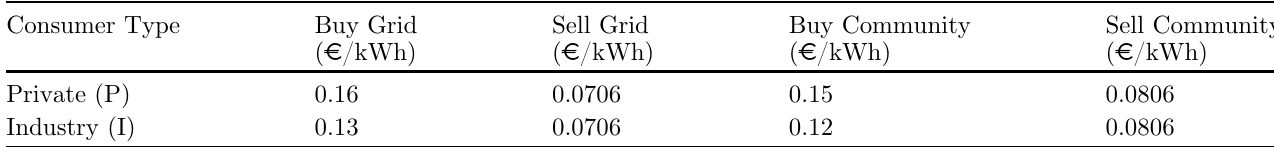
Table 2. Buy and sell prices for each consumer